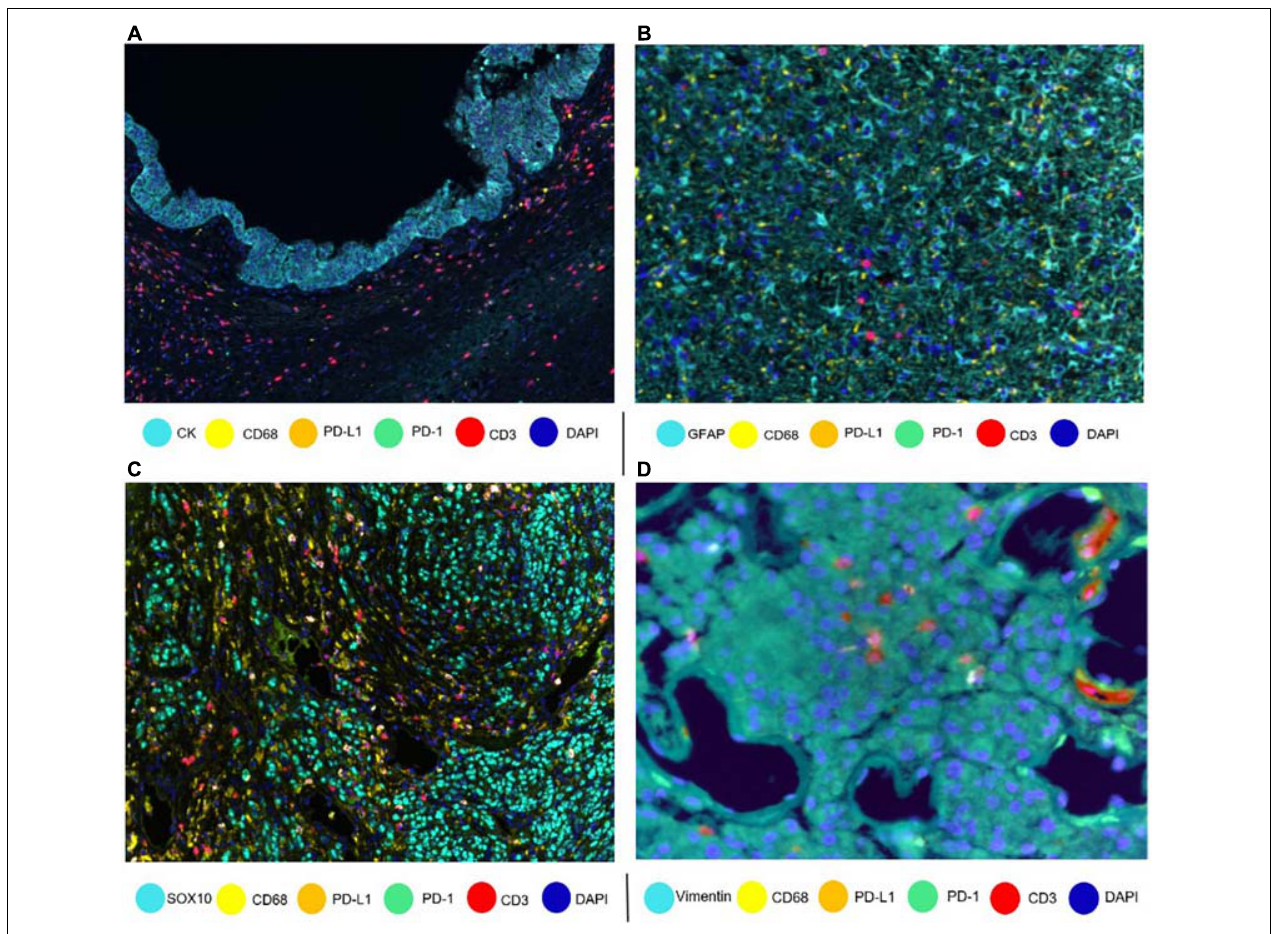
FIGURE 1 | Composites of tumor samples stained with different tumor and epithelium antibodies. (A) Intraductal papillary mucinous neoplasm epithelium with cytokeratin (CK). (B) Glioblastoma glial cells with glial fibrillar acidic protein (GFAP). (C) Melanoma with nuclear SOX10. (D) Sarcoma with